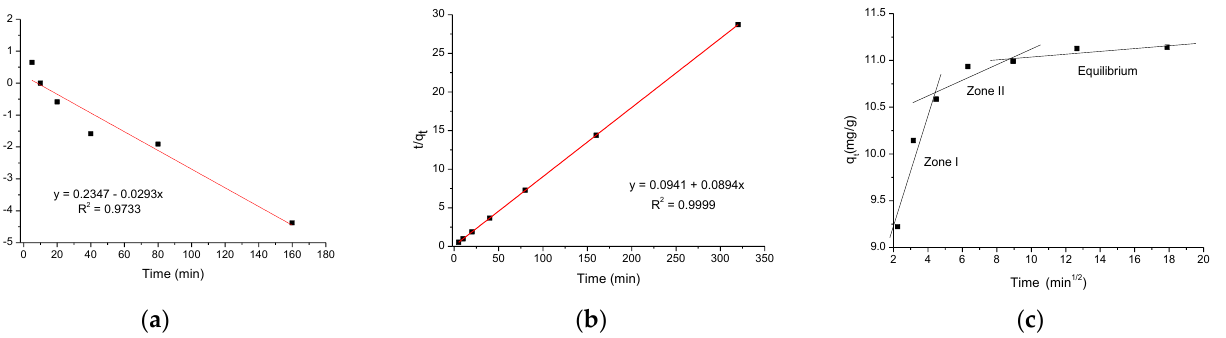
Figure 6. Kinetic models of enrofloxacin adsorption onto P. koidzumii sorbent (adsorbent dose 8 g/L; 100 mg ENR/L; pH 7; and temperature 298 K). ( a ) Pseudo-first-order, ( b ) pseudo-second-order, and ( c ) intraparticle diffusion models. Table 2. Kinetic parameters for the adsorption of enrofloxacin onto P. koidzumii sorbent. Kinetic